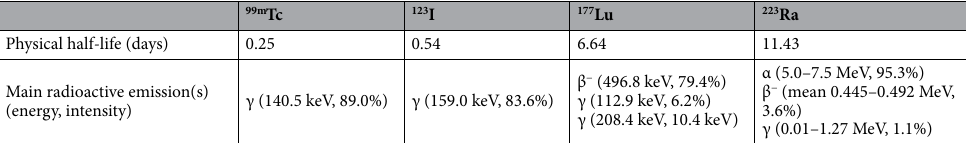
Table 1. Physical properties of the radionuclides used in this work.